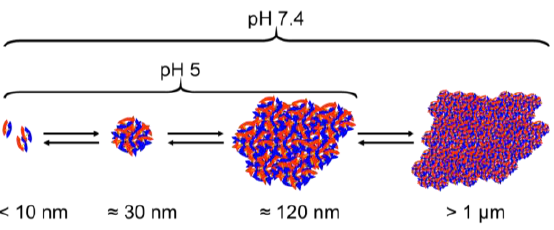
Figure 13. Schematic presentation of the apparent aggregation equilibrium of BMP-2 at pH 5 and pH